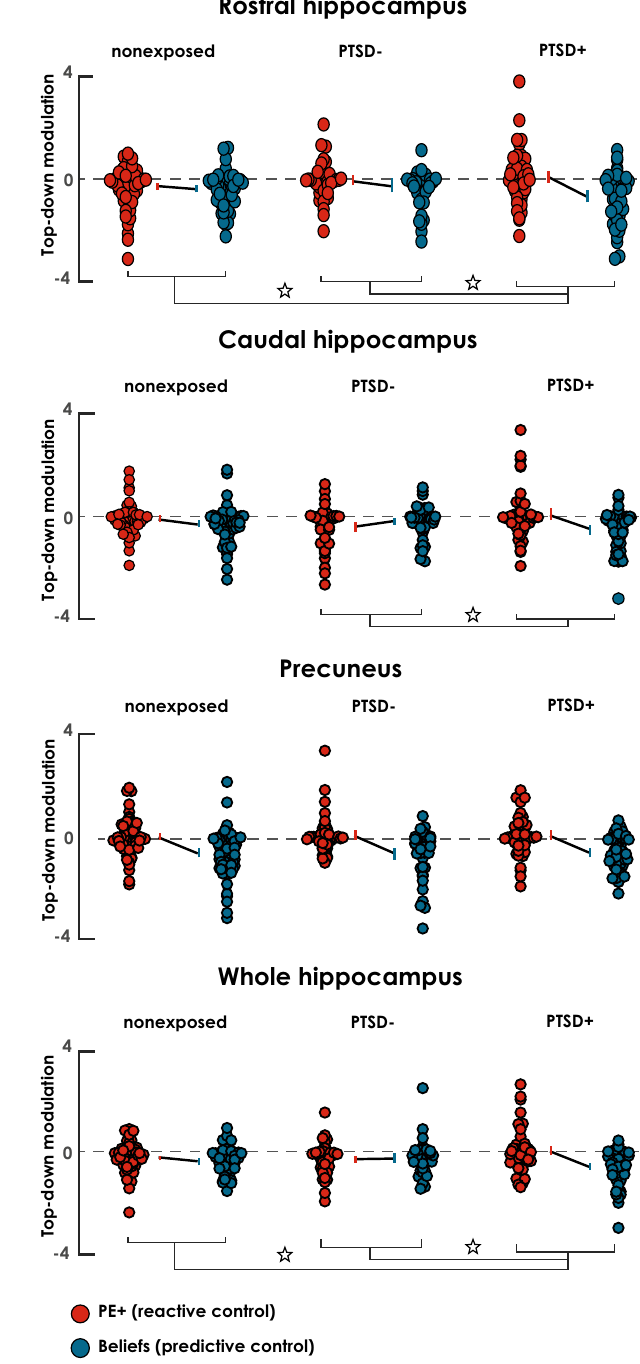
Beliefs (predictive control) Fig. 4 BMA of top-down coupling parameters during belief- and PE- driven suppression. Red and blue circles represent the modulation of PE + and beliefs on the top-down coupling between the MFG and the target regions, respectively, in non-exposed ( n sample size = 72), PTSD − ( n sample size = 46) and PTSD + ( n sample size = 55). Lines represent group average coupling parameters ± bootstrapped 95% CI of the group mean, and small circles represent individual participant coupling parameters. ‘ * ’ indicates signi fi cant interaction between groups and the balance in belief- driven predictive and PE-driven reactive control as shown by one-tailed t - tests at p FDR < 0.05. See Table 1 for statistical